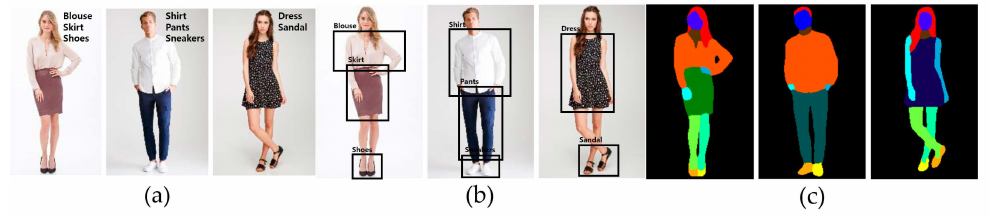
Figure 1. Image analysis applied to apparel. ( a ) Classification, ( b ) object recognition, and ( c )